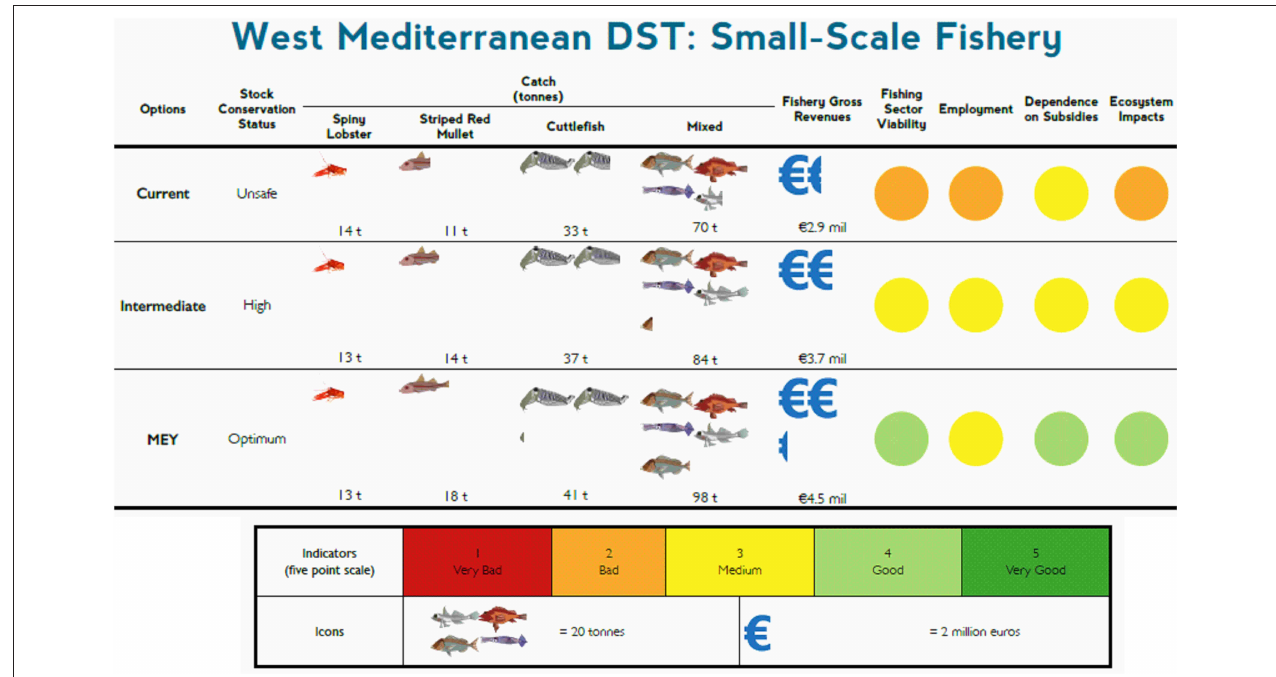
FIGURE 4 | Visualized form of the Decision Support Table from the small-scale